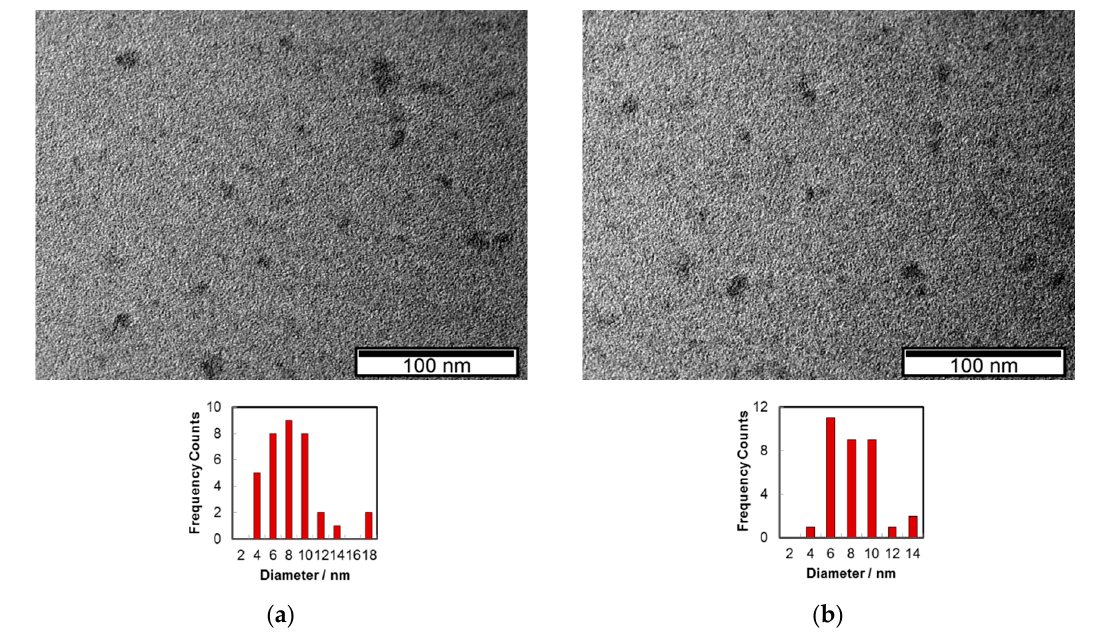
Figure 1. TEM images of C-dots, prepared from CIWW at 200 °C during 8 h, from two selected regions ( a ) and ( b ).